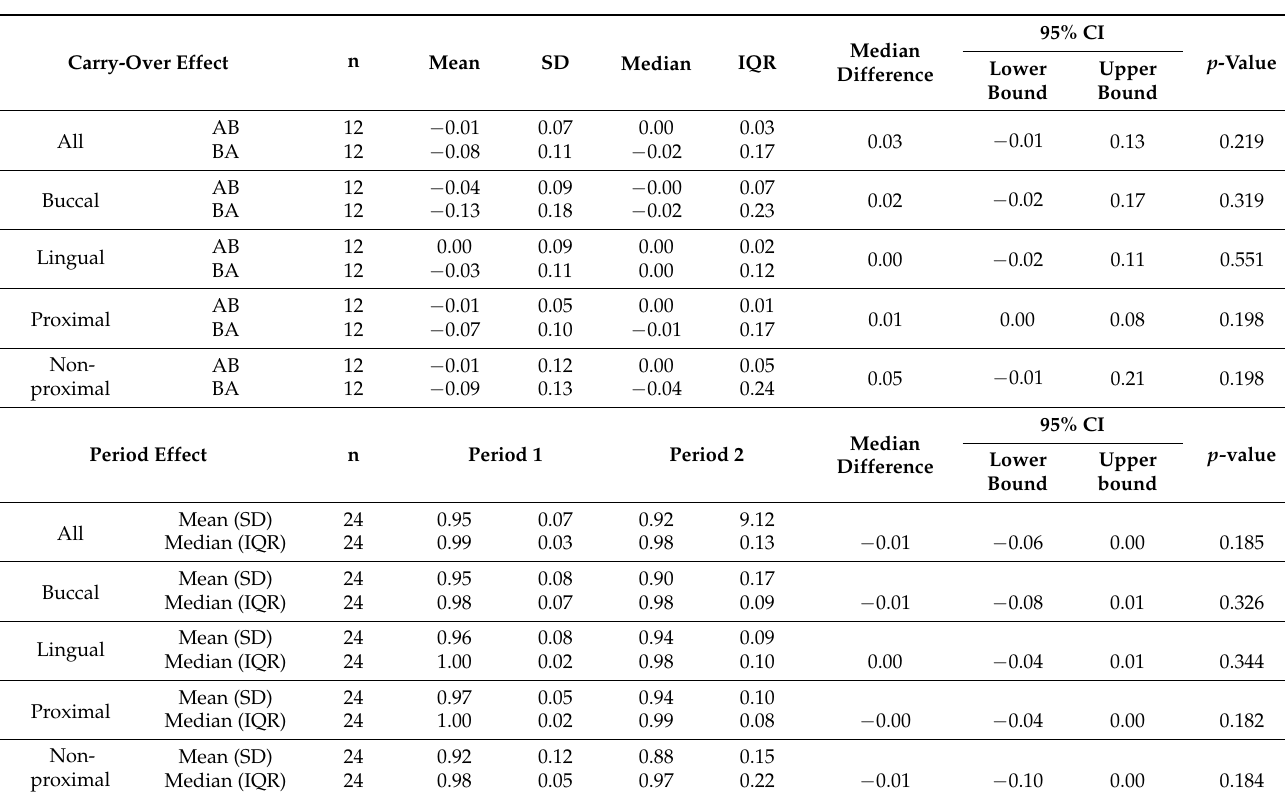
Table 2. Calculations for testing carry-over and period effect of the crossover trial based on the primary outcome, plaque index.